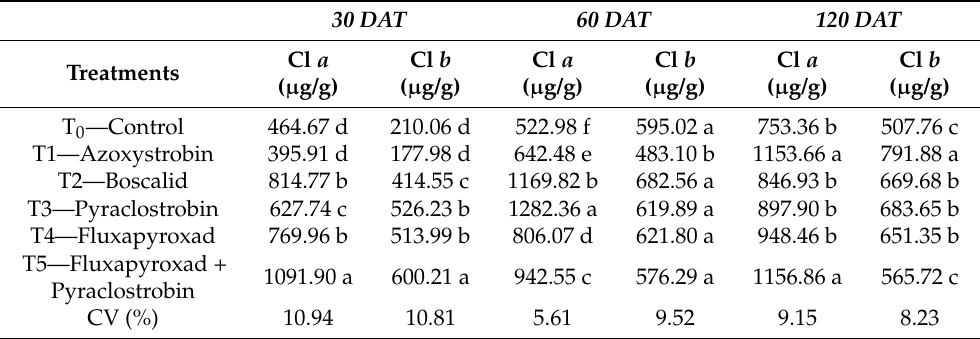
Table 2. Chlorophyll a (Cl a ) and chlorophyll b (Cl b ) content of tomato plants treated with fungicides with physiological effect, at different collection